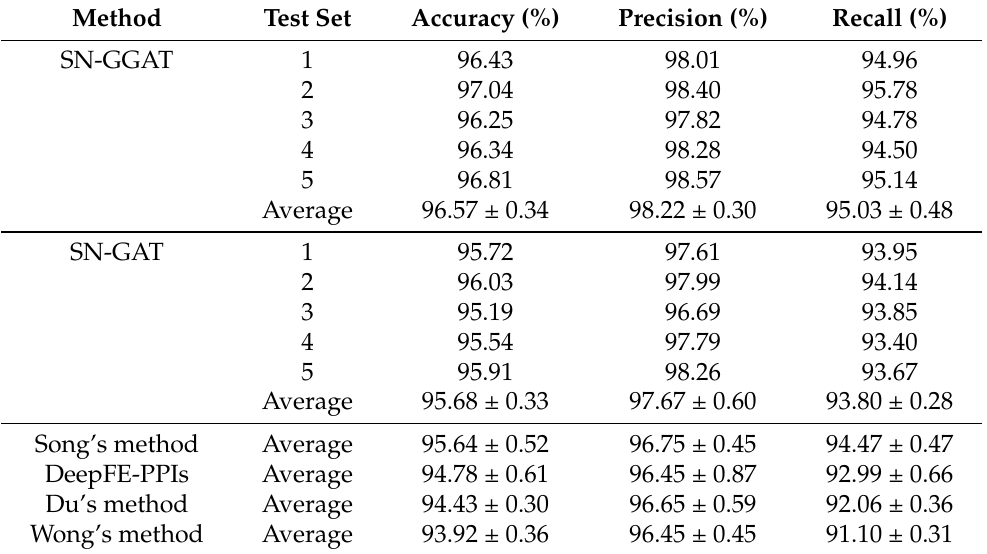
Table 1. Performance comparison of SN-GGAT with other state-of-the-art methods on the S. cerevisiae core